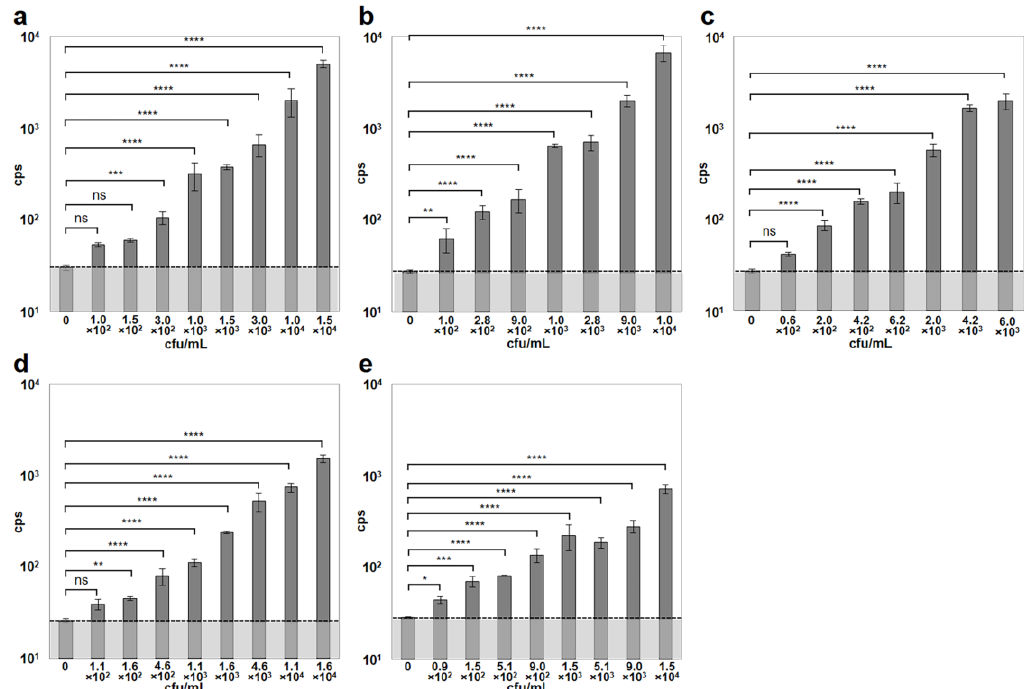
Figure 3. Detection of Listeria spp. strains employing the combined cell wall-binding domain-based magnetic separation (CBD-MS)/A511:: luxAB assay. Dilutions of pure cultures of five different Listeria strains representing different serovars were used for evaluating the combined CBD-MS/A511:: luxAB assay. ( a ) L. monocytogenes ScottA (serovar [SV] 4b); ( b ) L. monocytogenes EGDe (SV 1/2a); ( c ) L. monocytogenes WSLC 1001 (SV 1/2c); ( d ) L. ivanovii WSLC 3009 (SV 5); ( e ) L. innocua WSLC 2012 (SV 6b). The dotted horizontal bar indicates the level of background light emission (noise) of the assay, determined in the negative control sample (no bacteria). Asterisks indicate significant differences between values obtained from samples with bacteria and the respective control values. ****, p < 0.0001; ***, p < 0.001; **, p < 0.01; *, p < 0.05; ns, non-significant.